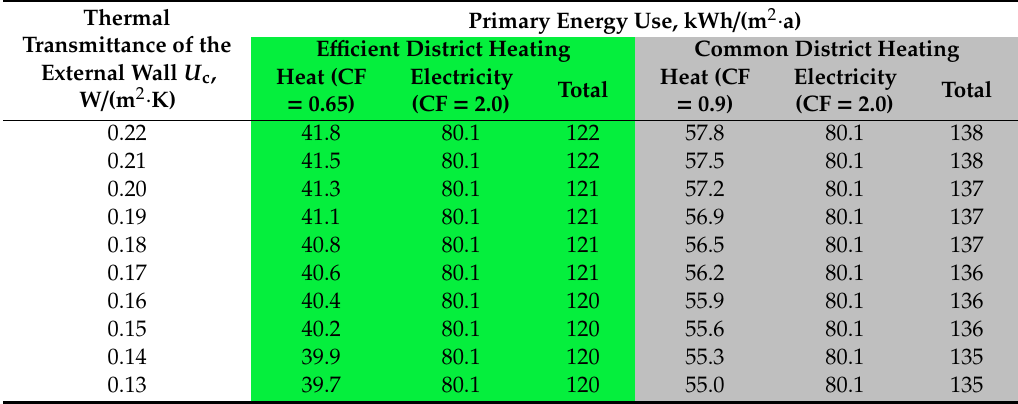
Table 8. Influence of the heat source on the use of primary energy by the apartment building.